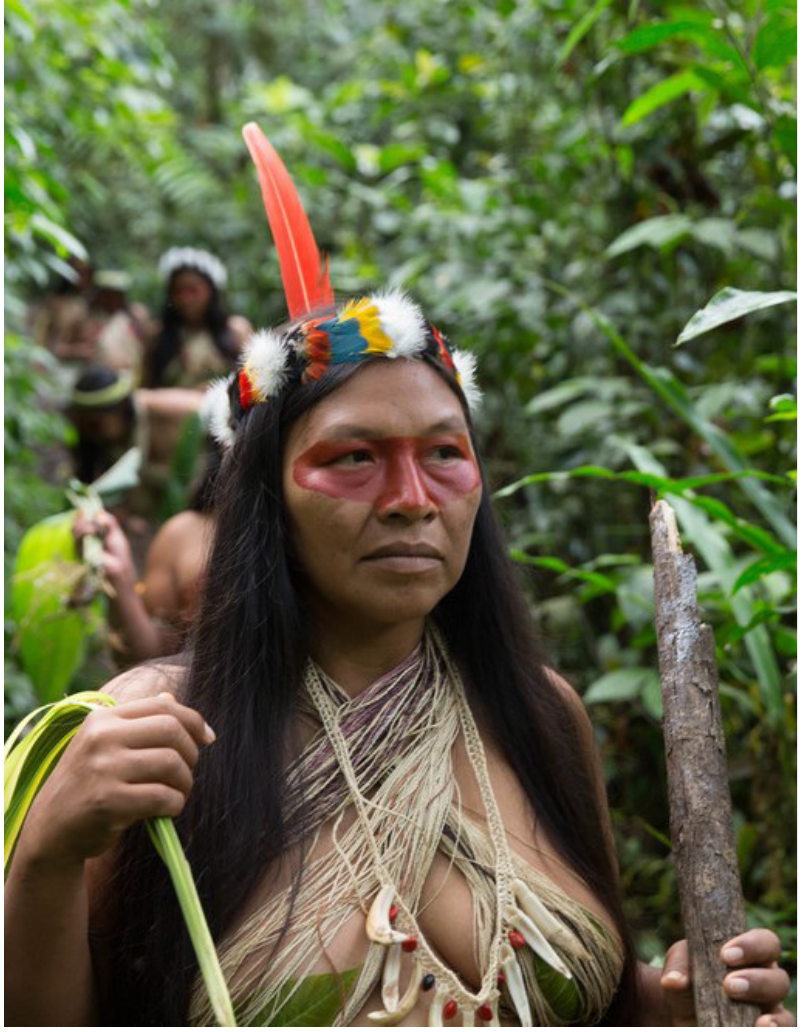
FIG. 3 Woman in the forest. Image Credit: © Creative commons [https://www.ifad.org/ en/web/latest/-/regional-meetings-in-preparation-for-the-global-meeting-of-the-